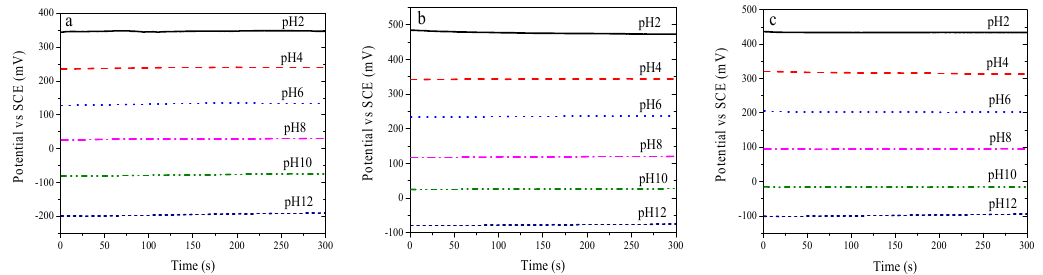
Figure 4. Response time, measured in different pH test solutions for IrO X electrodes fabricated at 750 °C ( a ), 800 °C ( b ), and 850 °C ( c ).